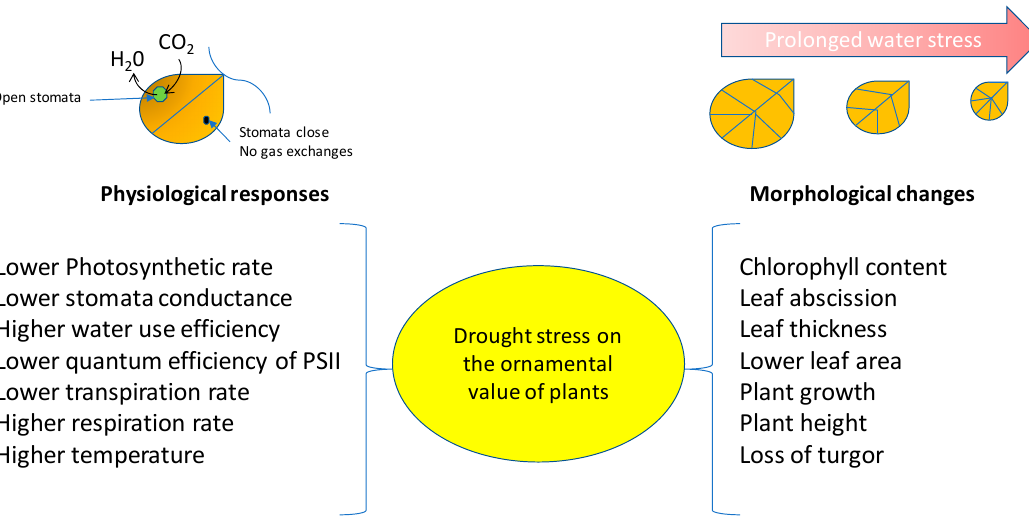
Figure 2. Physiological and morphological changes of plants exposed to reduced water availability. The magnitude of changes depends on the intensity of the stress.